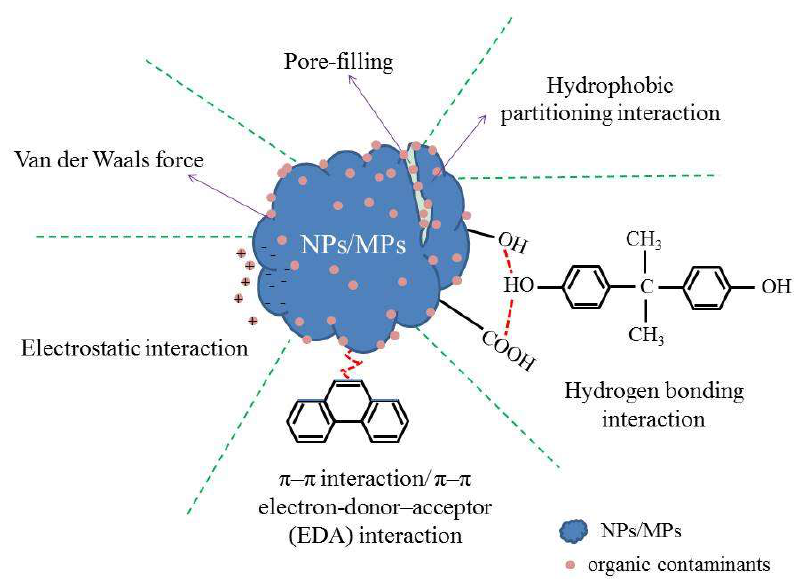
Figure 1. The sorption mechanisms of organic contaminants to NPs/MPs.